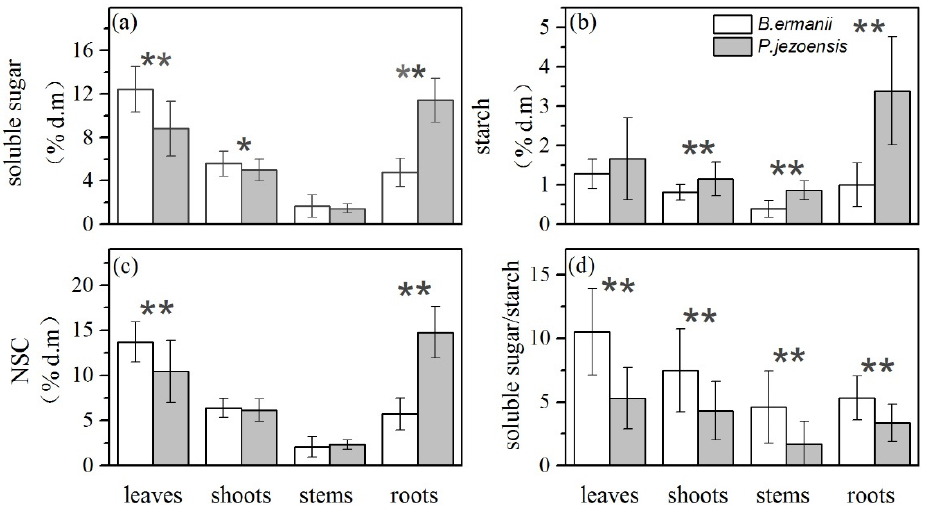
Figure 1. Concentrations of (a) soluble sugars, (b) starch, (c) NSC and (d) soluble sugar/starch ratio (mean ± SD) of all elevations for B. ermanii and P. jezoensis tissues. Asterisks (*, p < 0.05; **, p < 0.01) indicate statistically significant differences between B. ermanii and P. jezoensis with each tissue as determined by T-test.